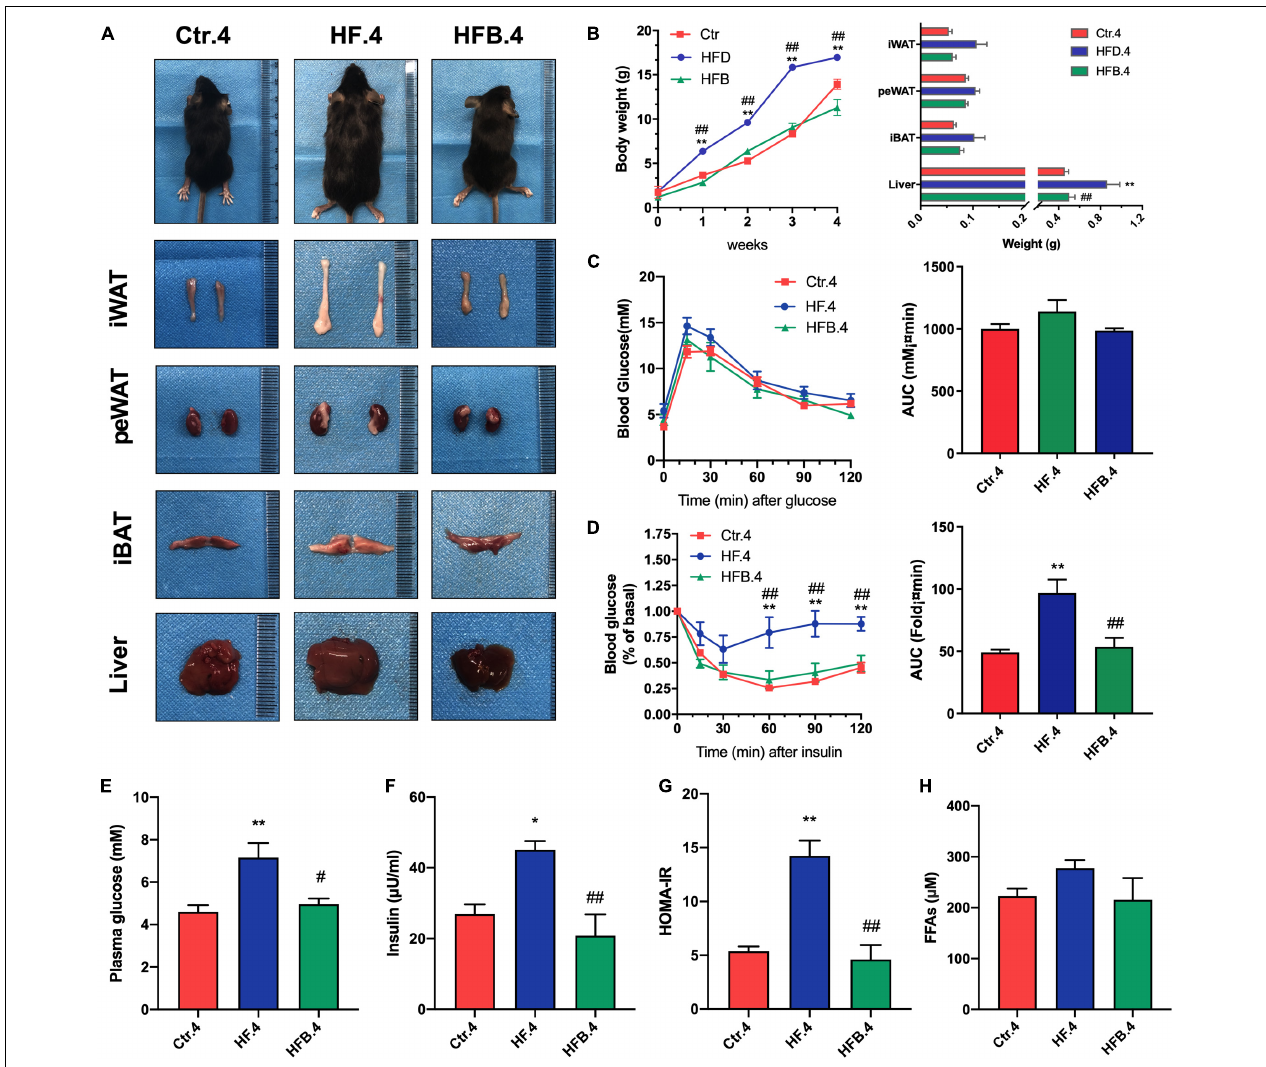
FIGURE 3 | Maternal betaine ameliorates glucose and lipid metabolism induced by early-life high-fat diet in 4-week-old offspring. Offspring mice were analyzed at 4 weeks of age. (A) General picture of body composition; (B) body weight (left) and body composition (right) changes; (C) oral glucose tolerance test (left) and the area under the curve (right); (D) insulin tolerance test (left) and the area under the curve (right); (E) fasting plasma glucose; (F) fasting insulin level; (G) HOMA-IR; (H) FFAs. Ctr.4, 4-week-old offspring of dams fed with the standard control diet; HF.4, 4-week-old offspring of dams fed with the high-fat diet; HFB.4, 4-week-old offspring of dams fed with the high-fat diet with betaine. HOMA-IR, homeostasis model assessment of insulin resistance; FFAs, free fatty acids. Data are expressed as means ± S.E.M. ( n = 4–6/group). One-way and two-way ANOVA; * p < 0.05 and ** p < 0.01 vs. Ctr, # p < 0.05 and ## p < 0.01 vs.